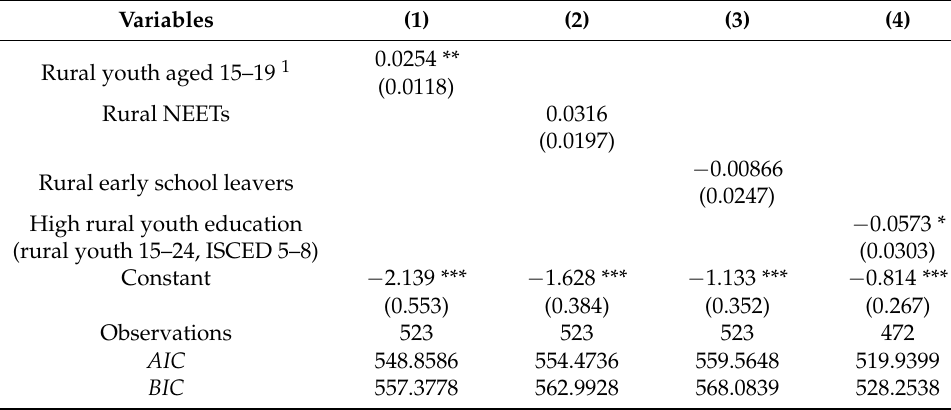
Table 2. Mention of Rural Youth Education and the demand structure.